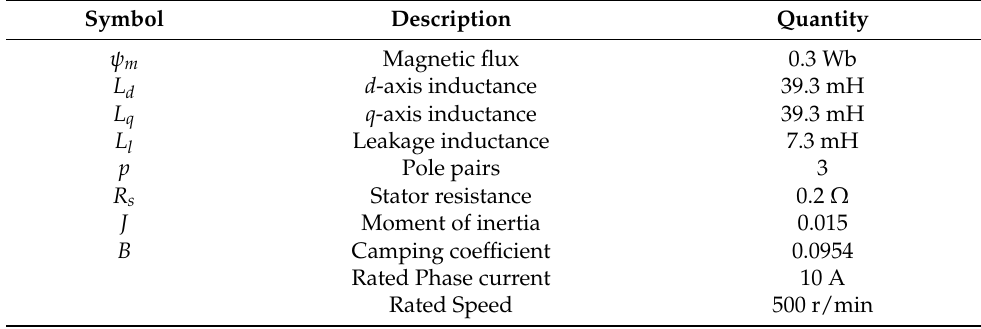
Table 9. Parameters of